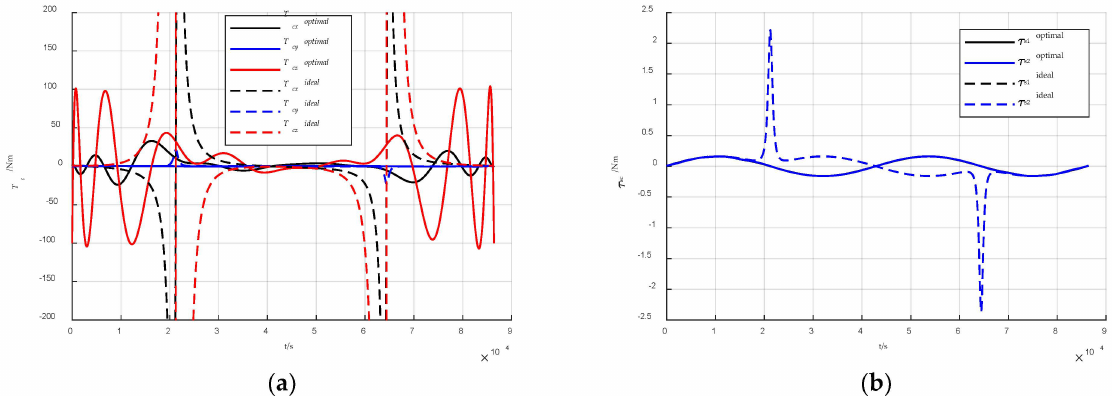
Figure 6. Control torque history around equinox. ( a ) Control torque history of the components of T c ; ( b ) control torque history of τ scj